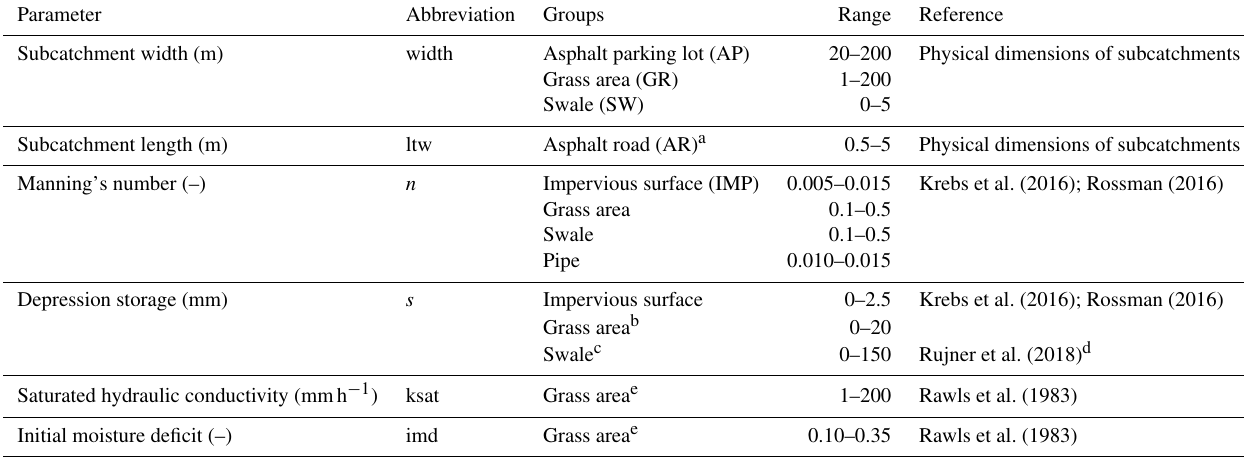
Table 2. Calibration parameters and their ranges.